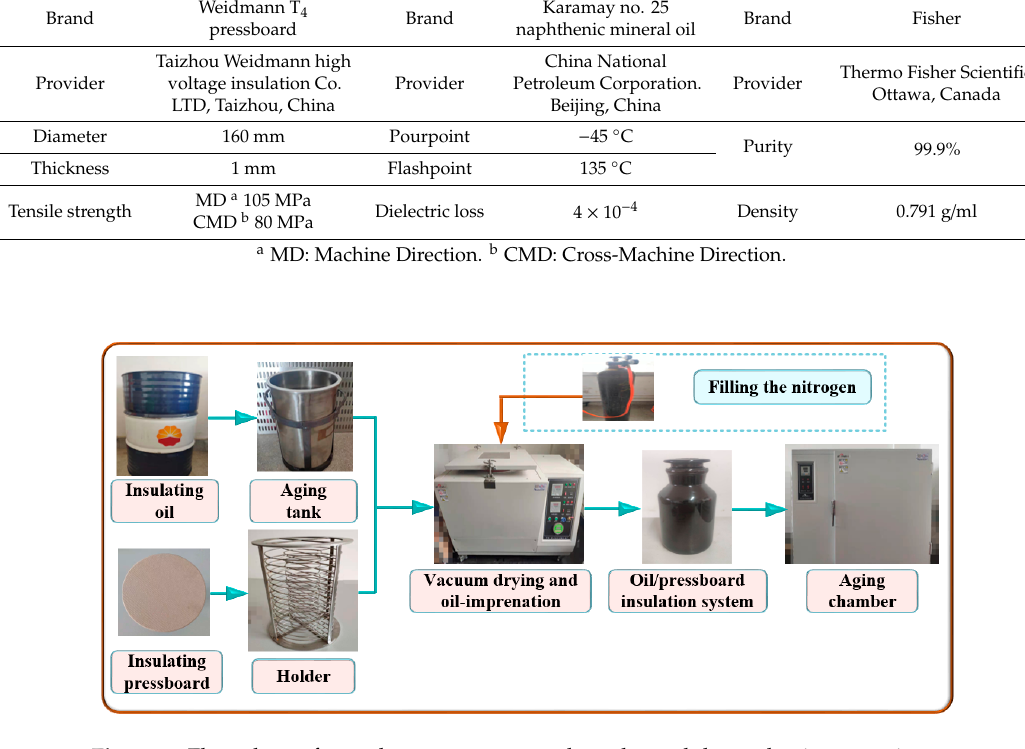
Table 1. Parameters of the materials.